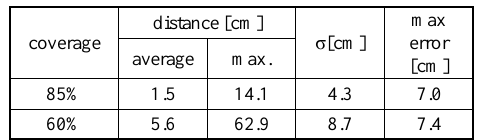
Table 3. Results of the accuracy assessment of point clouds generated based on video frames with varying overlap, with reference to TLS data Table 3 and the above images show a strong correlation